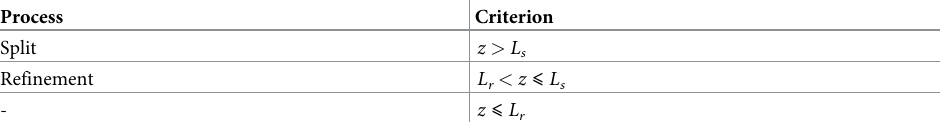
Table 2. Execution criteria for split and refinement processes. L decomposition, and